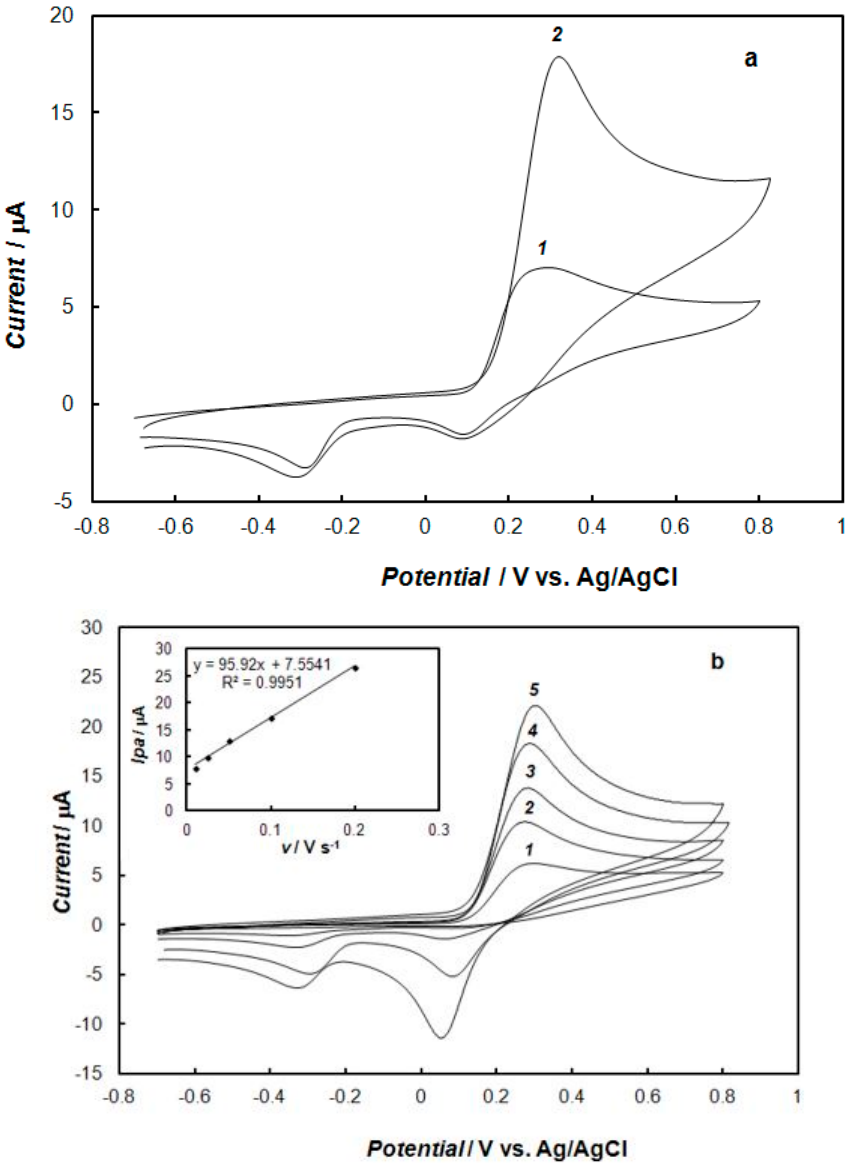
Figure 5. Cyclic voltammograms recorded: ( a ) At the bare gold electrode (curve 1 ) and at the gold electrode modified with the polypyrrole—MCM-48 nanocomposite (curve 2 ) in 0.1 M of phosphate buffer solution (pH 7.4) containing 1 mM of dopamine, and at a potential sweep rate of 0.1 V s − 1 ; ( b ) at the gold electrode modified with the polypyrrole—MCM-48 nanocomposite in 0.1 M of phosphate buffer solution (pH 7.4) containing 1 mM of dopamine, and for different potential sweep rates, being ( 1 ) 0.01 V s − 1 , ( 2 ) 0.025 V s − 1 , ( 3 ) 0.05 V s − 1 , ( 4 ) 0.1 V s − 1 , and ( 5 ) 0.2 V s − 1 . The inset in panel ( b ) shows